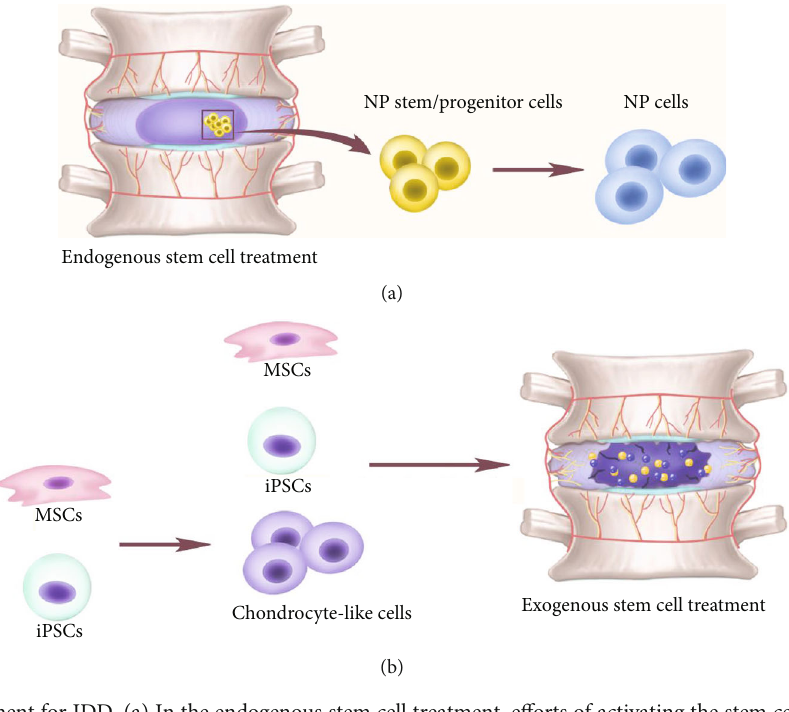
Figure 2: Stem cell treatment for IDD. (a) In the endogenous stem cell treatment, e ff orts of activating the stem cells in the NP are made to improve the degeneration of the IVD. (b) In the exogenous stem cell treatment, stem cells from other tissues like MSCs and iPSCs are delivered into the disc via intradiscal injection with or without the di ff erentiation before utilization. Table 1: The cell surface markers